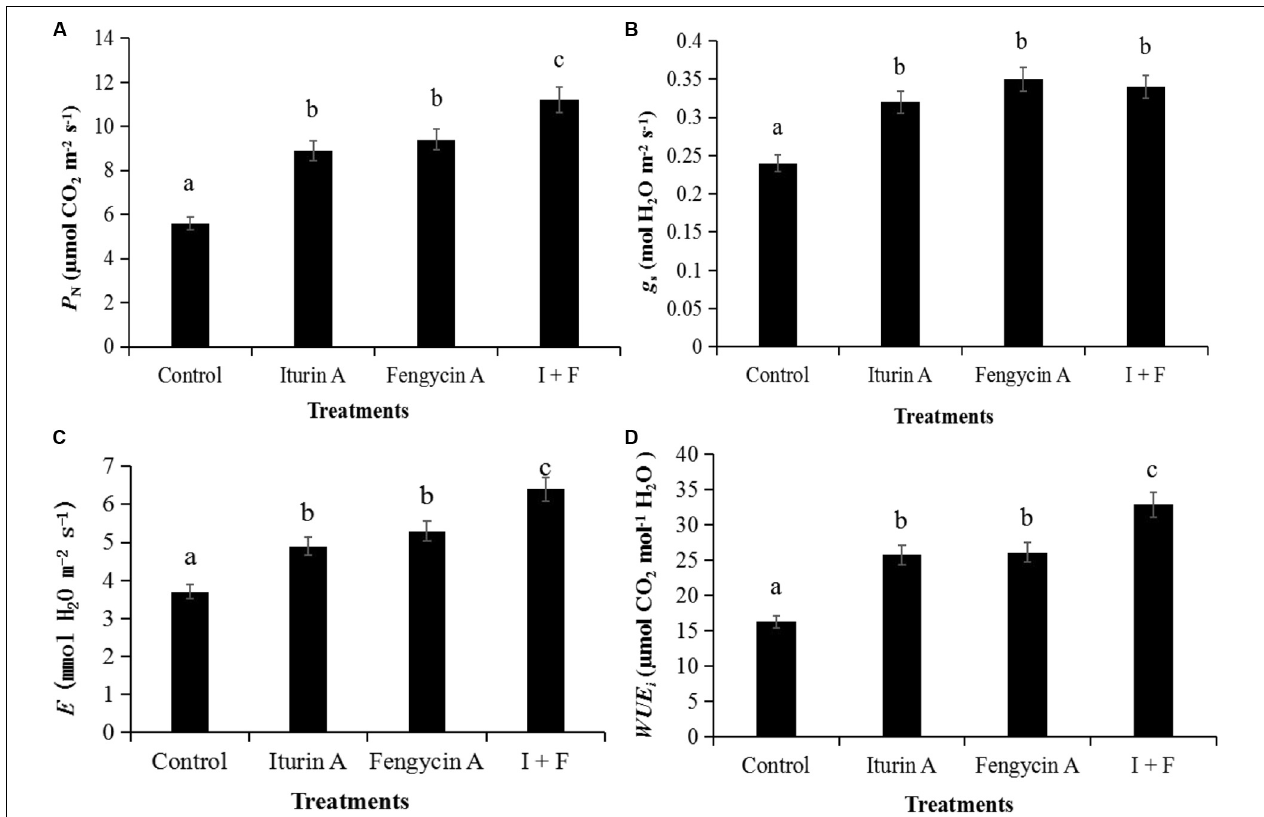
FIGURE 4 | Parameters of photosynthetic efficiency in field trials. (A) Net photosynthetic rate ( P N ); (B) Stomatal conductance ( g s ); (C) Transpiration rate ( E ); (D) Intrinsic water use efficiency ( WUE i ). I + F, Iturin A (25 µ g/mL) + Fengycin A (25 µ g/mL), 1:1 in volume. Data are presented as the average ± the standard deviation, and the different letters a–c indicate a significant difference between treatment groups within a parameter ( P <